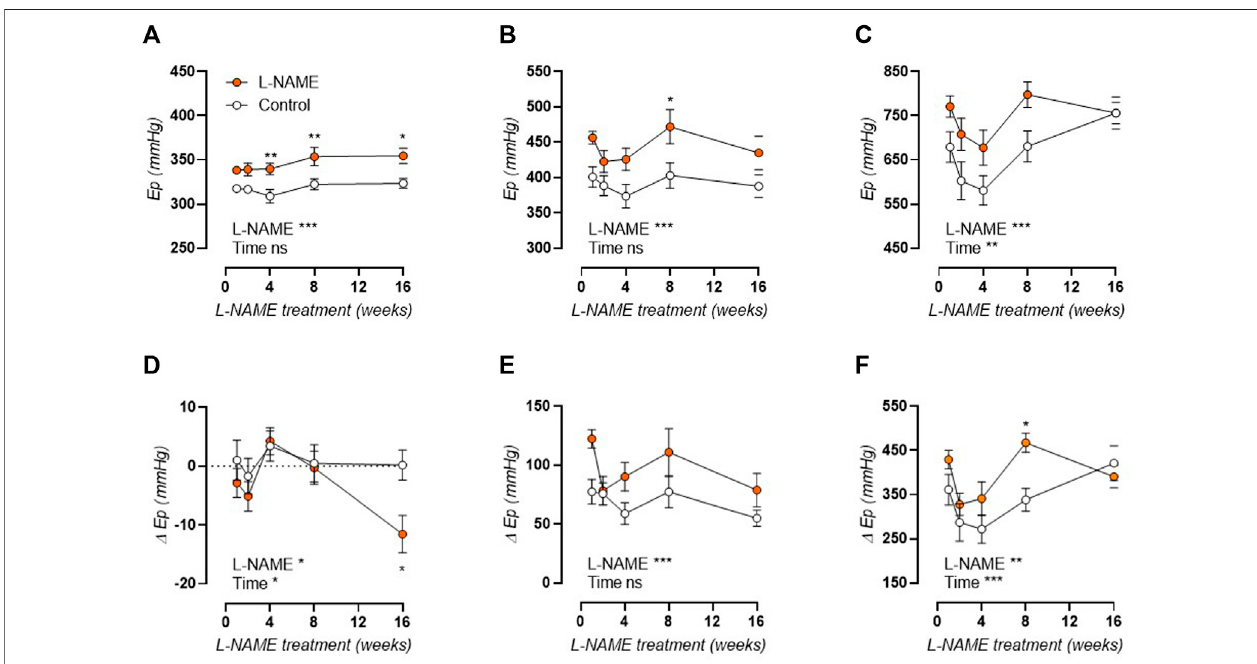
FIGURE 7 | Contraction independent and dependent aortic stiffness in longitudinal L-NAME treated mice. Peterson modulus (E p ) at isobaric 80 – 120 mmHg distendingpressureisshownintheabsenceofextracellularcalcium(0Ca, (A) ),inthepresenceof2 μ M PE (B) ,andinthepresenceof2 μ M PEand300 μ M L-NAME (C) inL-NAMEtreated(n ≥ 7)andcontrol(n ≥ 9)mice.StiffnessintheseconditionswasfurthercomparedtobaselineE p valuesinKrebs-Ringersolutiontoobtaintheeffectof extracellularcalciumremoval (D) ,2 μ M PEcontraction (E) ,and2 μ M PEwith300 μ M L-NAMEcontraction (F) onaorticstiffness.Statisticalanalysisusingtwo-way ANOVA. Overall signi fi cance (bottom) and post-hoc signi fi cance (in graph) are listed. * p < 0.05, ** p < 0.01, *** p < 0.001.